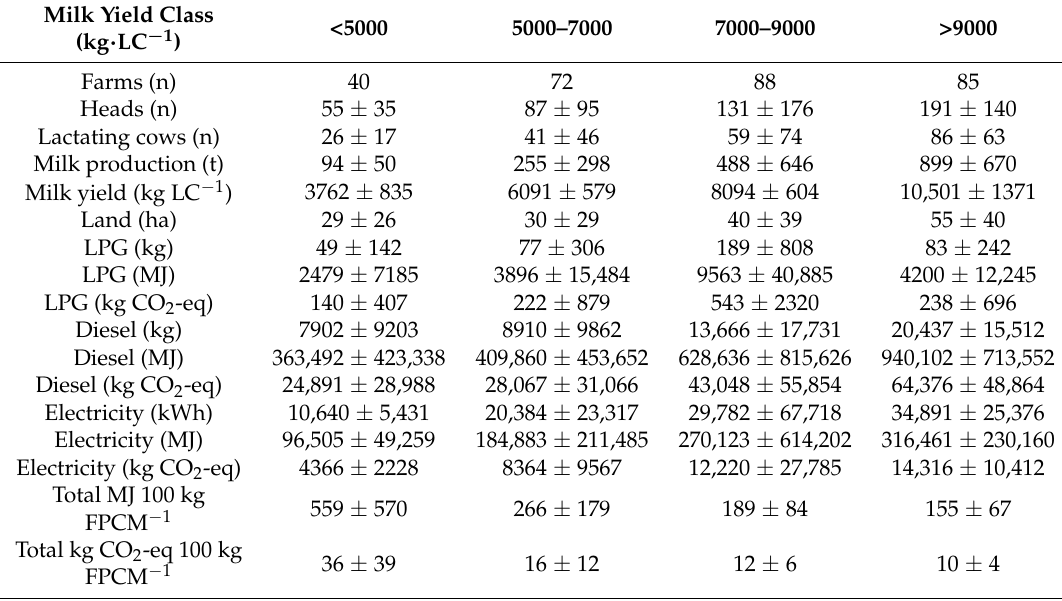
Table 4. Primary energy consumption and carbon dioxide emissions on a yearly basis, averages and standard deviation for milk yield classes (N =